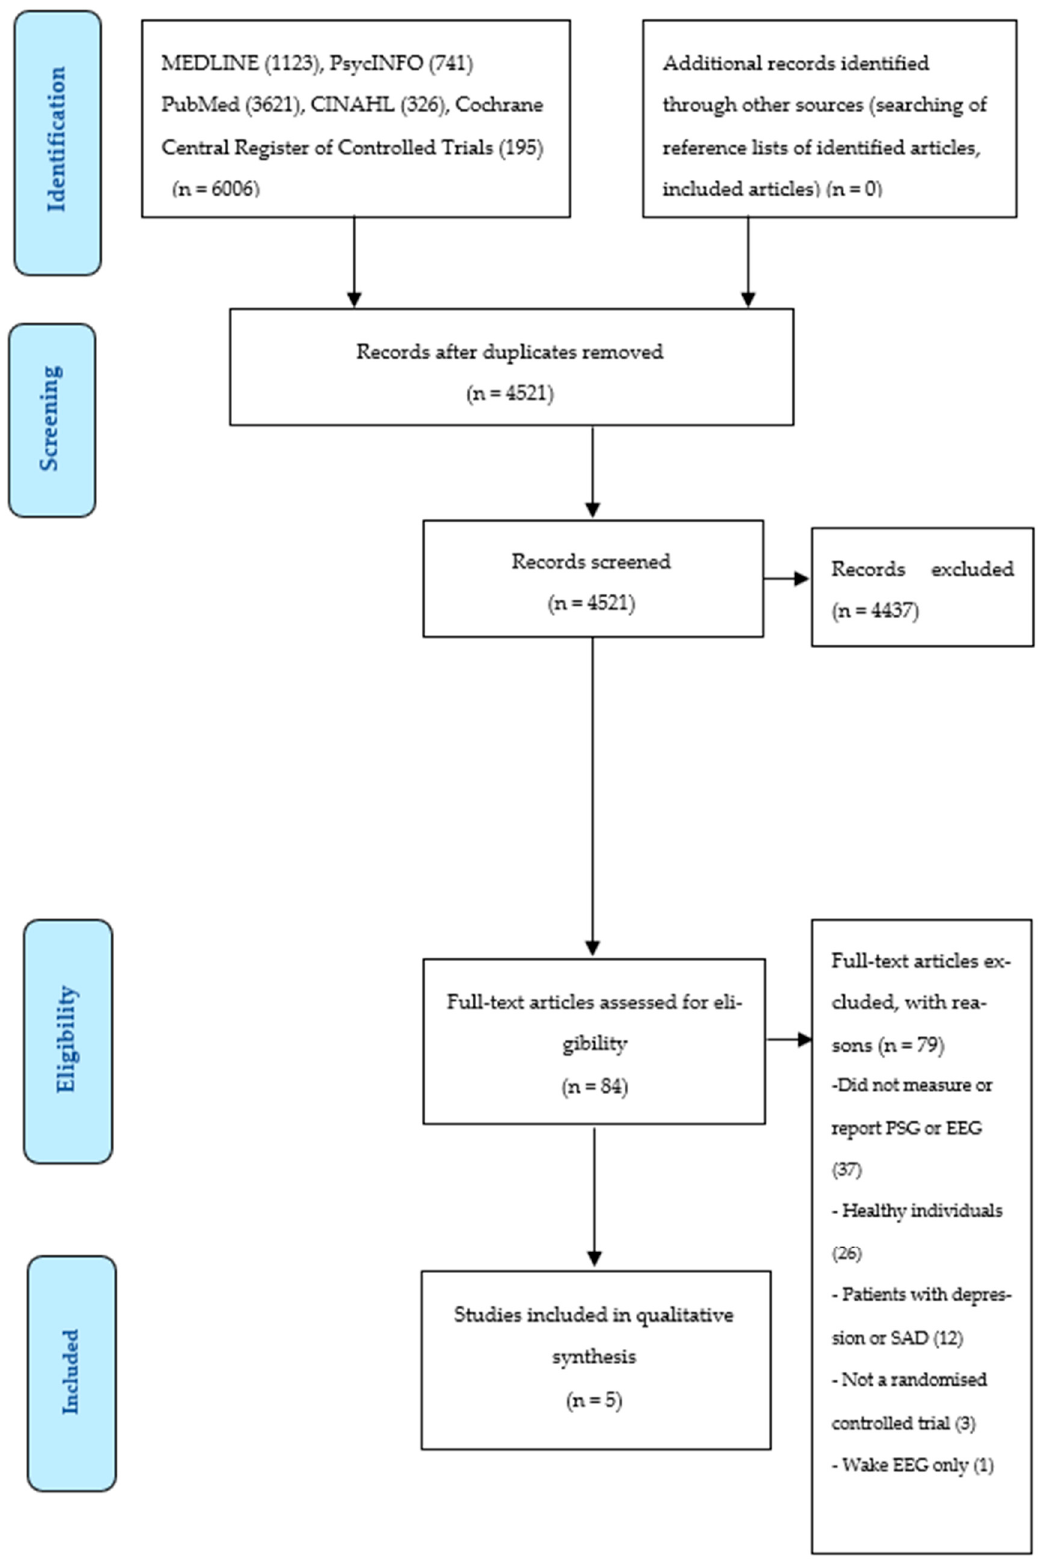
Figure 1. PRISMA flow diagram of search process and numerical outcomes. Abbreviations: EEG: electroencephalography, PSG: polysomnography, SAD: seasonal affective disorder.